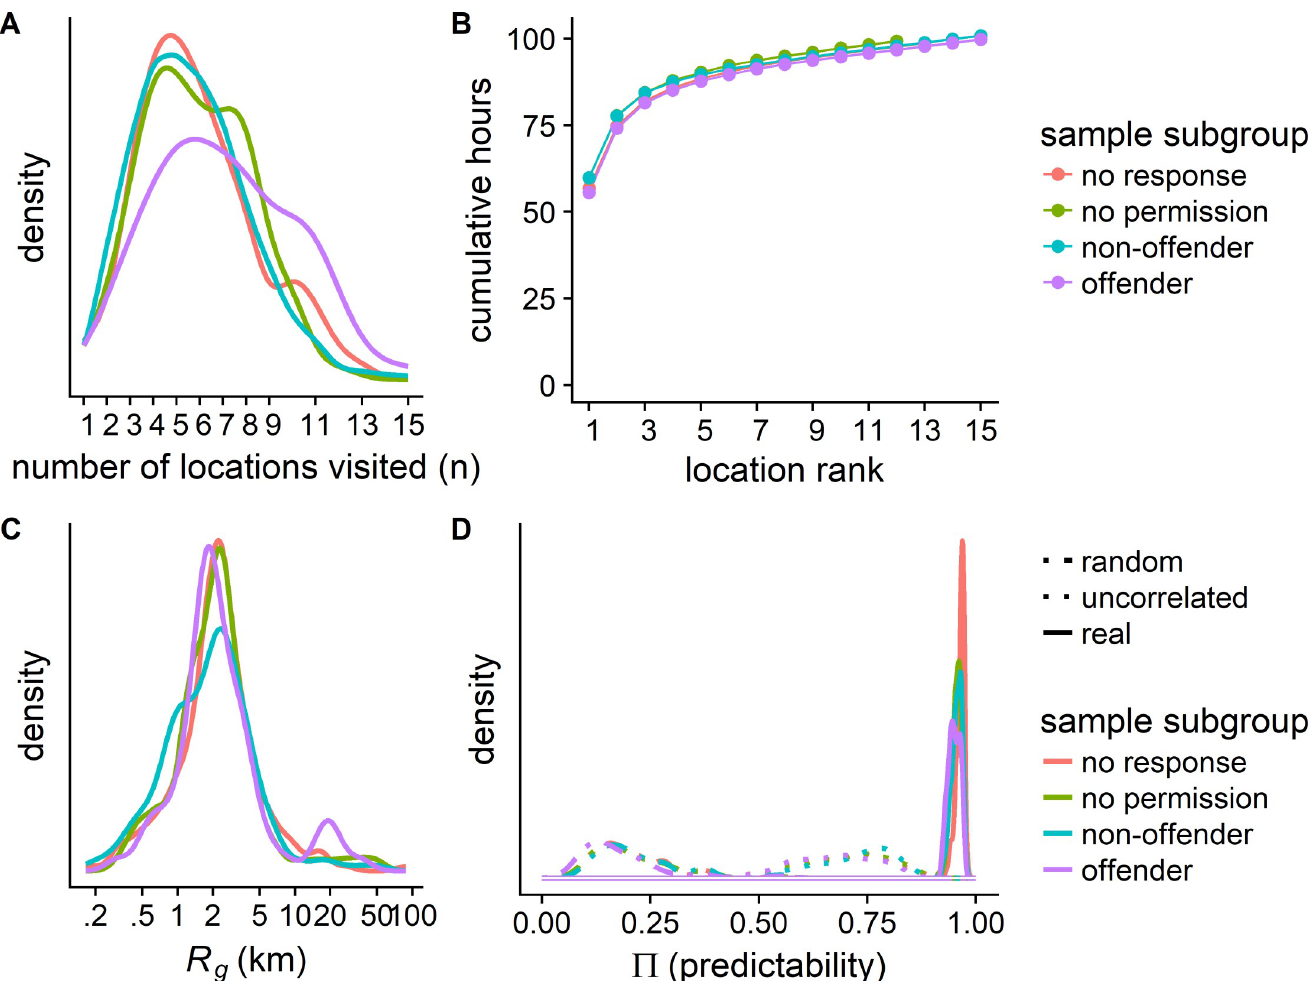
Fig 1. Key features of mobility are similar amongst subgroups of the sample. The sample can be segmented into four mutually exclusive subgroups: (1) participants (n = 228) who could not be asked for permission to link their registry data to their survey responses, (2) participants (n = 98) who did not give permission to link their registry data to their survey responses, (3) participants (n = 447) who gave permission and did not commit crimes subsequently, and (4) participants (n = 70) who gave permission and who became offenders during the study period. ( A ) On average, offenders visited 1 location more than individuals in the other three groups (see S4 Table). ( B ) All participants spent about 75 percent of their time in their two most visited locations (home and school). ( C ) The radius of gyration is approximately 3km and displays minor but insignificant differences between the four groups (see S5 Table). ( D ) The three predictability measures differed slightly across the groups, with a very slight tendency for offenders to be less predictable (see S6–S8 Tables). Densities in (A), (C) and (D) were calculated with the Gaussian kernel density estimator proposed by Scott [37]. Values are not labeled along the Y axis is they have no useful interpretation here.